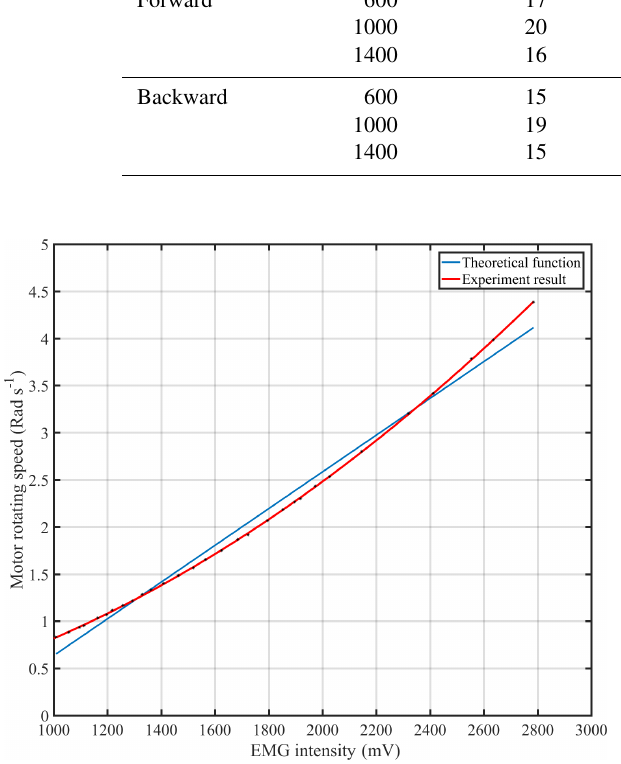
Figure 7. The relationship of motor rotating speed and the intensity of EMG.